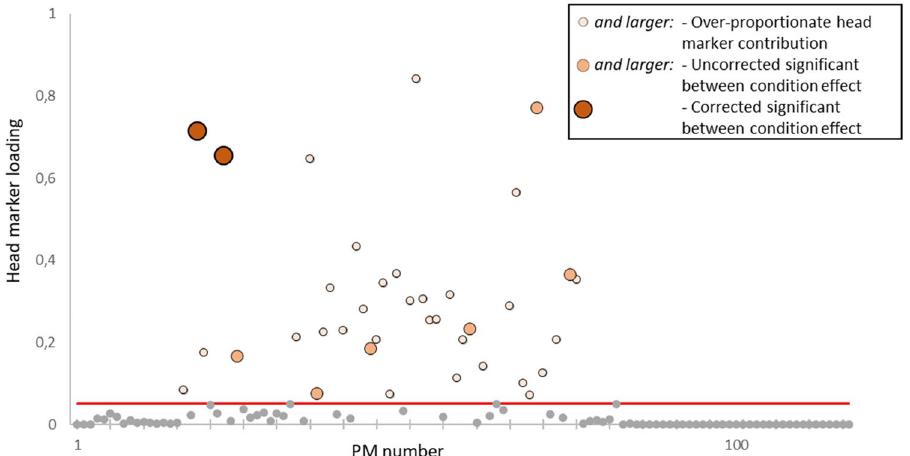
Figure 2. Sum of the head-marker loading per PM (range: PM1–PM117). The horizontal line represents the threshold value of 5% (approximate body mass represented by the head), indicating that loadings above this line have relatively high head activity. Thirty-seven PCs were found with a combined head marker loading above the threshold. Shading and size of markers above threshold indicates between-condition differences in a Friedman test, where the smallest markers (light shade) show no difference, the medium sized markers (medium shade) show a difference with an uncorrected alpha of 0.05 and the largest (darkest) markers show significant differences even with an alpha corrected for 37 parallel comparisons. It is important to note here that in all PMs that show between condition effects, head movement is not isolated but at least 20% of variance is found in distributed